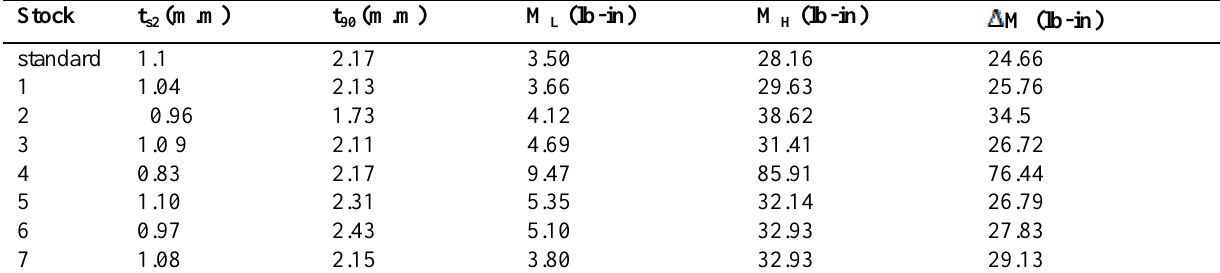
Rheological Test